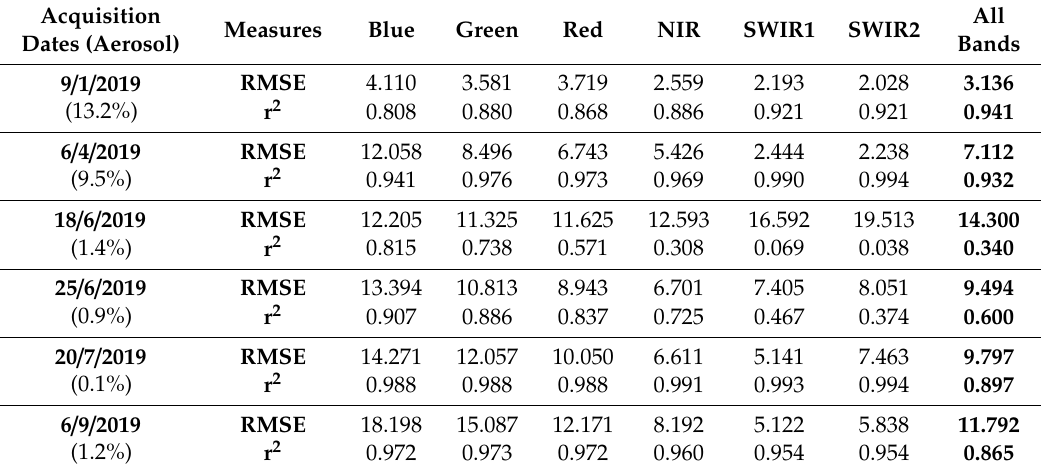
Table 2. Band-by-band RMSE (% reflectance units) and coe ffi cient of determination (r 2 ) between high-level aerosol (SR aerosol) on the SS1 for each date is shown in the first column between brackets.